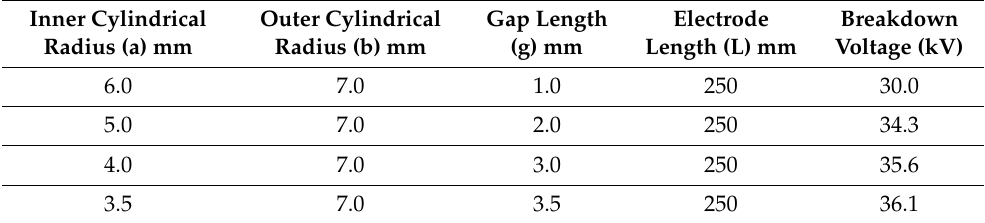
Table 5. Breakdown voltage of mineral oil with 0.05 wt% nanoparticle concentration.